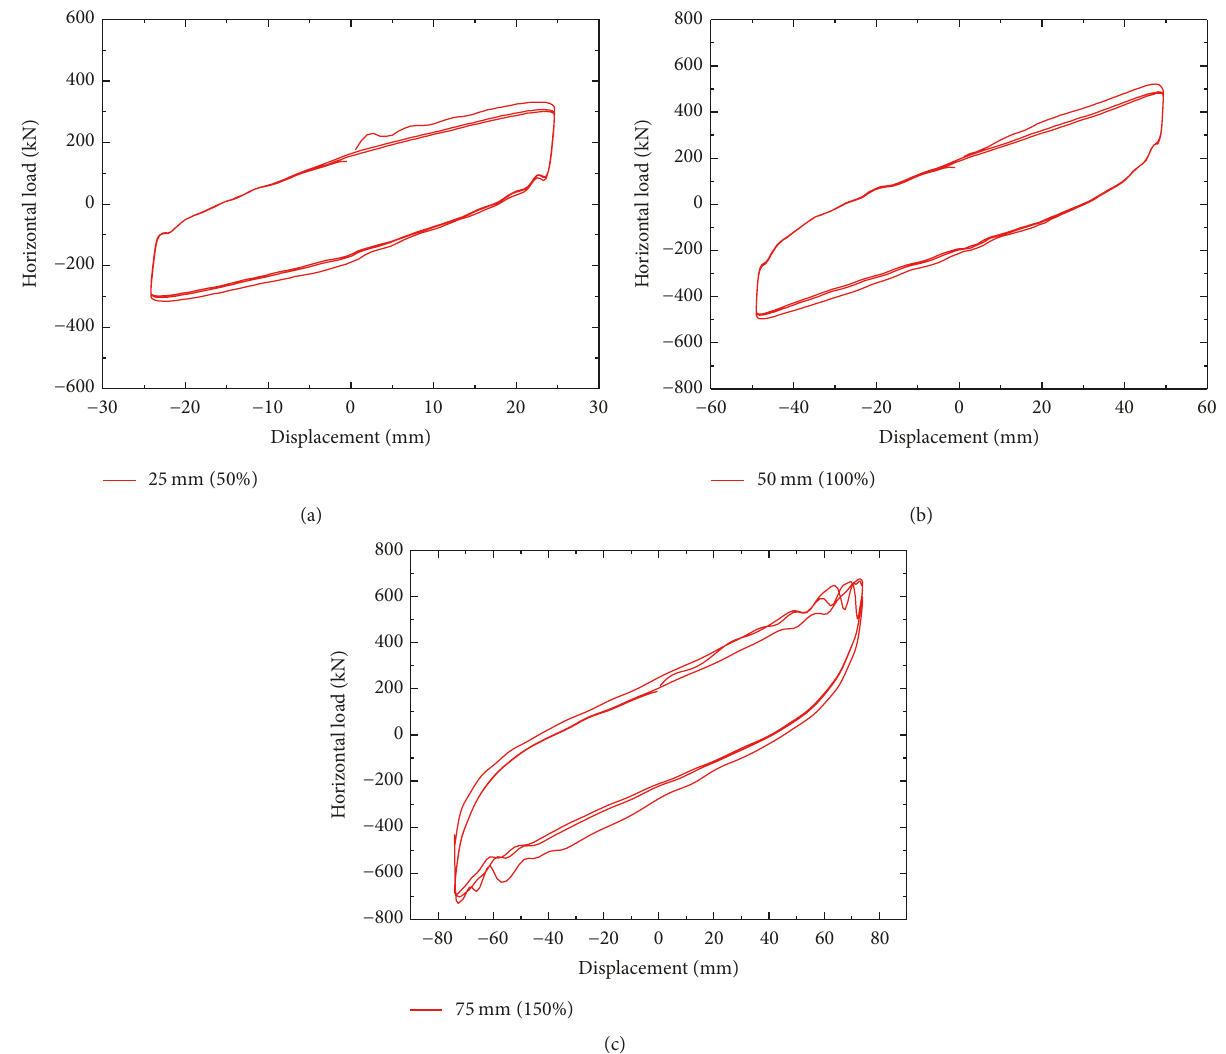
Figure 10: Curves of the shearing strain correlation test: (a) 50%, (b) 100%, and (c)